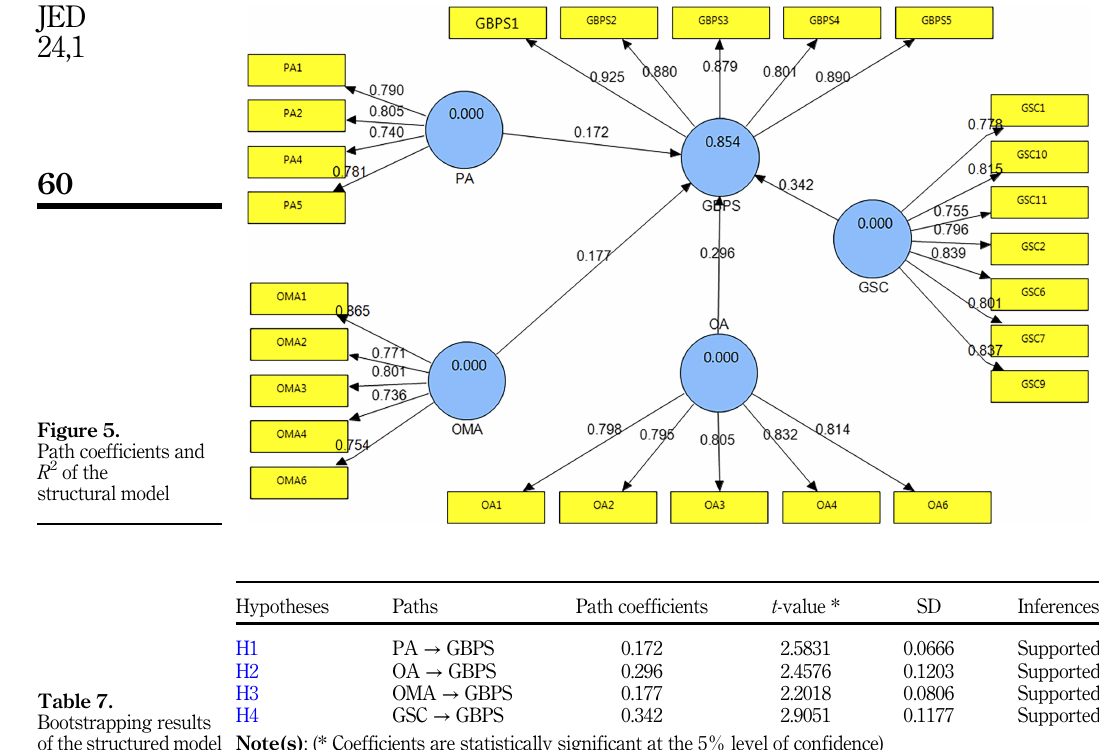
Table 7. Bootstrapping results of the structured